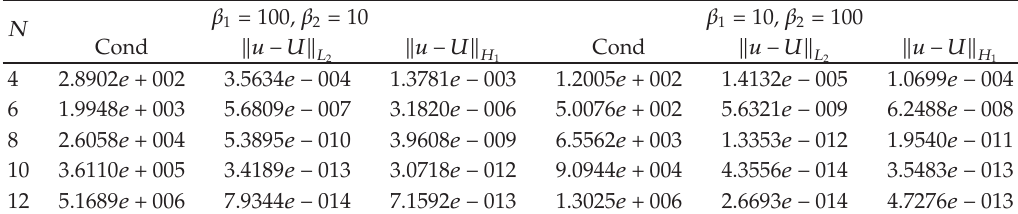
(cid:4) 100, β (cid:4) 10 (cid:6) . 1 2